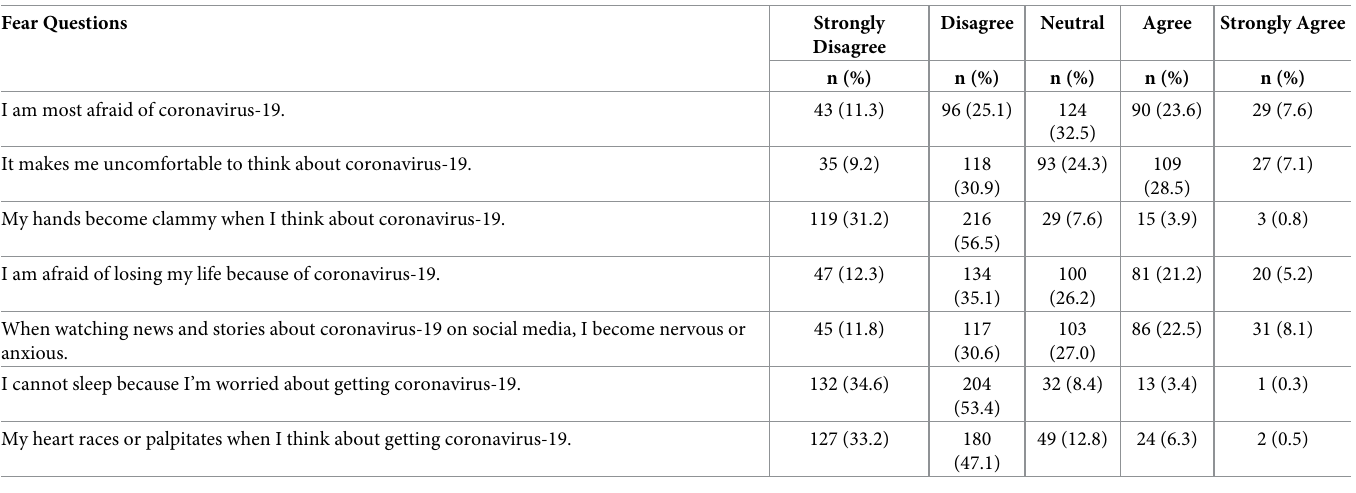
Table 3. Fear related to covid-19 among respondents (N = 382) (distribution of responses). Fear